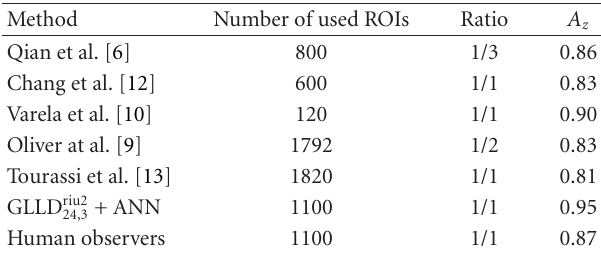
Table 8: Presented A z values for di ff erent methods in the state-of- the-art aiming at mass detection and that of the proposed